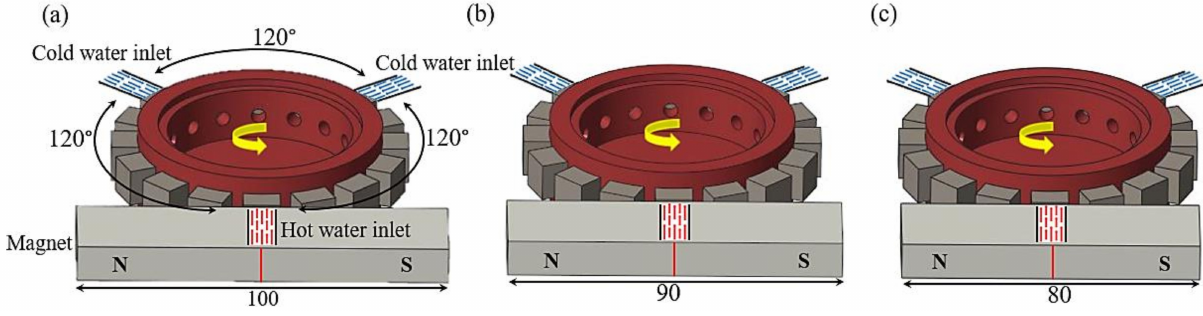
Figure 4. Simulated models of a thermomagnetic heat engine, consisting of different sizes of magnets and two cold- and a hot-water inlet located at an angle of 120 ◦ : ( a ) thermomagnetic engine consists of 100 mm magnet, ( b ) thermomagnetic engine consists of 90 mm magnet, ( c ) thermomagnetic engine consists of 80 mm